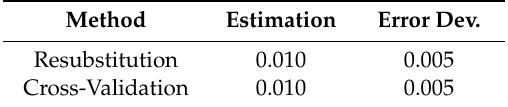
Table 13. Estimation risk for using WhatsApp (CHAID method).